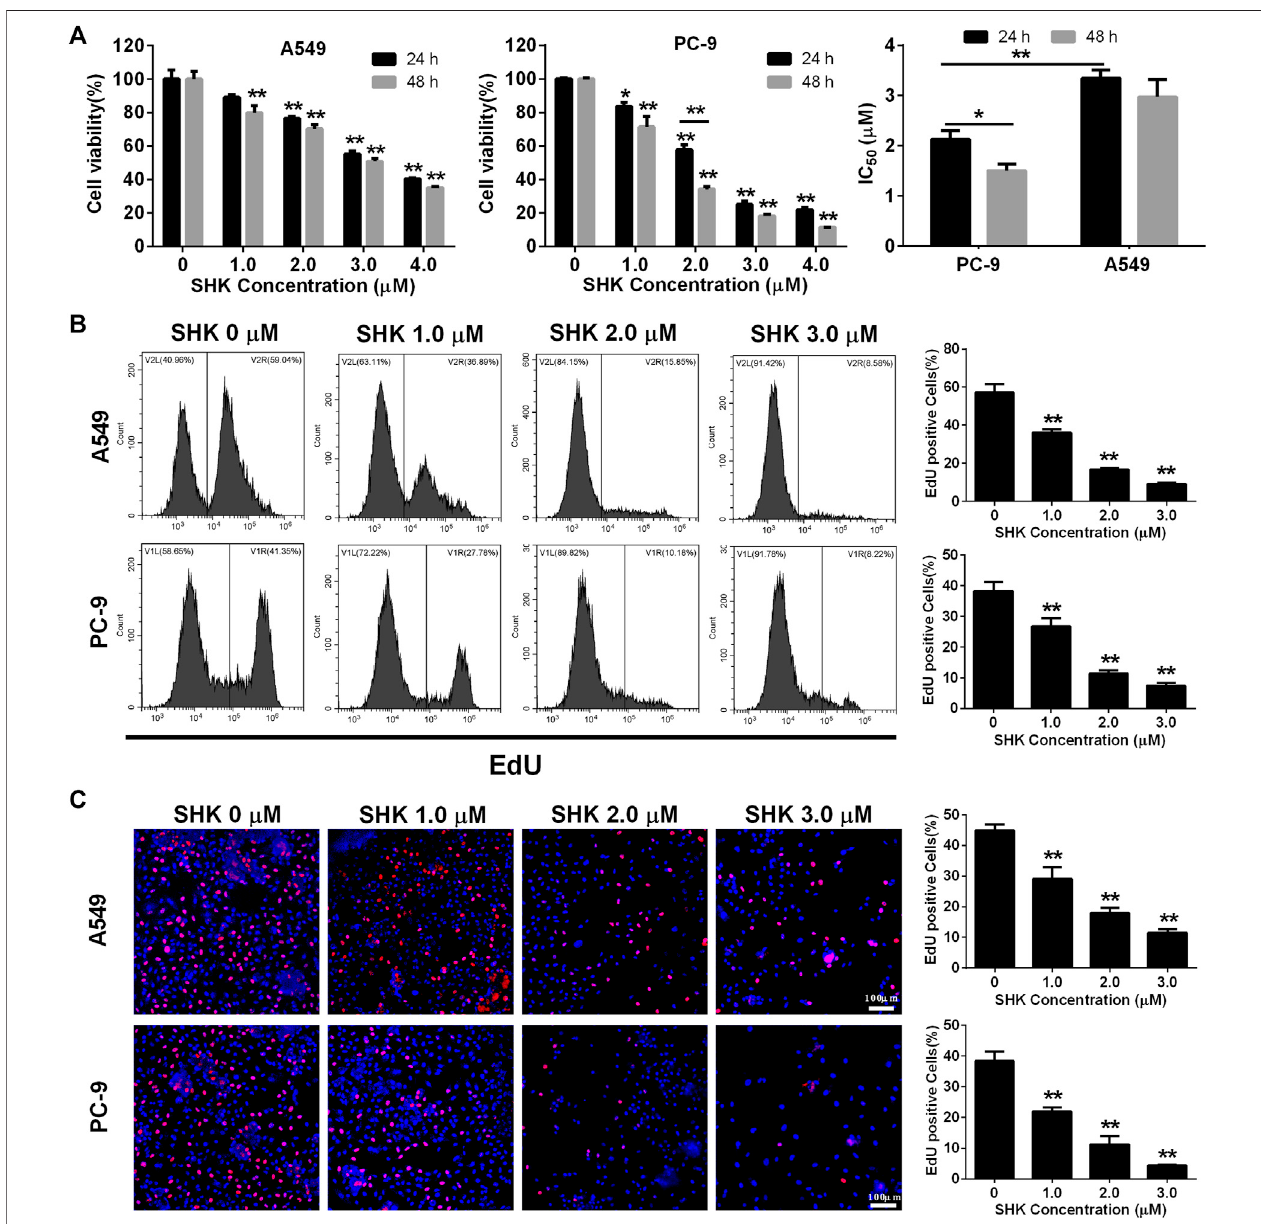
FIGURE 1 | The inhibitory effect of SHK on A549 cells and PC-9 cells. (A) CCK-8 assay, (B) EdU assay on A549 (upper panel) and PC-9 (lower panel) cells detected by fl ow cytometry, and (C) EdU assay on A549 (upper panel) and PC-9 (lower panel) cells recorded by fl uorescence microscope. All measurements were carried out in triplicates, and data are given as mean ± SD ( n (cid:2) 3). *fnlowast p < 0.05, ** p < 0.01.